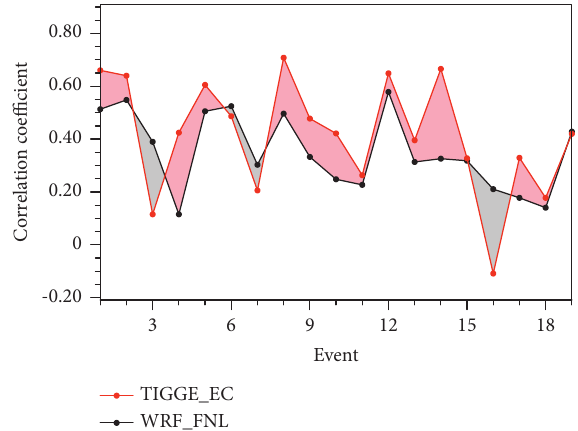
Figure 1: Correlation with OBS of the cumulative precipitation forecast by WRF_FNL (black) and TIGGE_EC